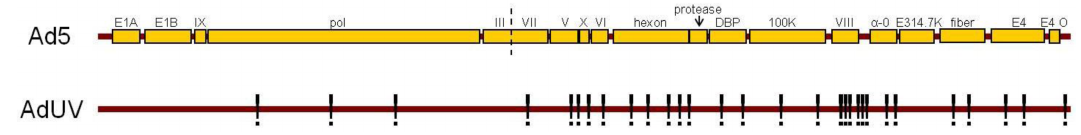
Figure 7. AdUV DNA mutation map. 30 mutations were detected in the AdUV genome in total, relative to the adenovirus serotype 5 (Ad5) reference sequences. No mutations were present in the early genes. The majority of these mutations were contained in adenovirus late genes. Mutations are indicated by exclamation points. Data was collected via ION torrent DNA sequencing and viewed with open source IGV software.